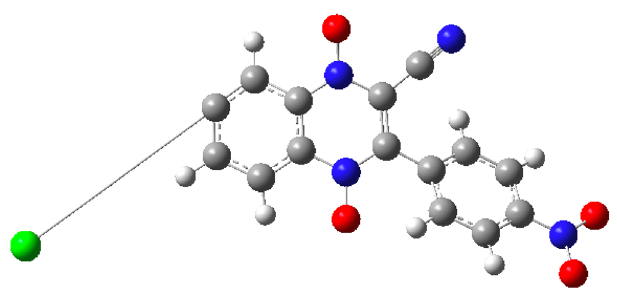
Figure 5. The anion structures of derivative A1 in resonance after accepting an extra electron during Wave 1. Chemical structures drawn in MarvinSketch [20].